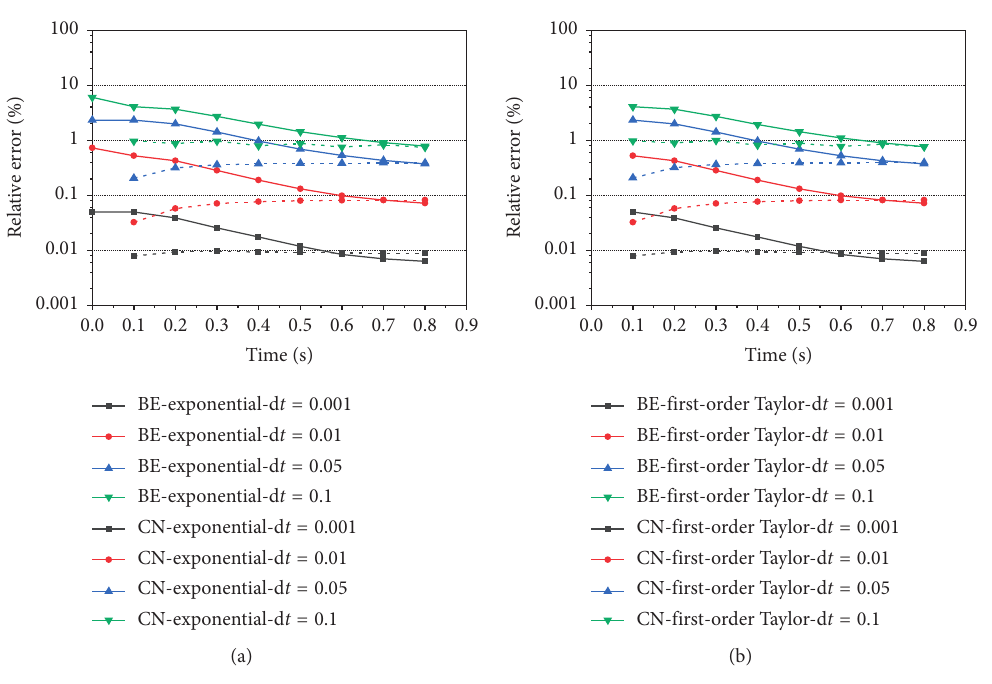
Figure 7: The relative power error of exponential expansion and first-order Taylor expansion in different time discretization and time steps.